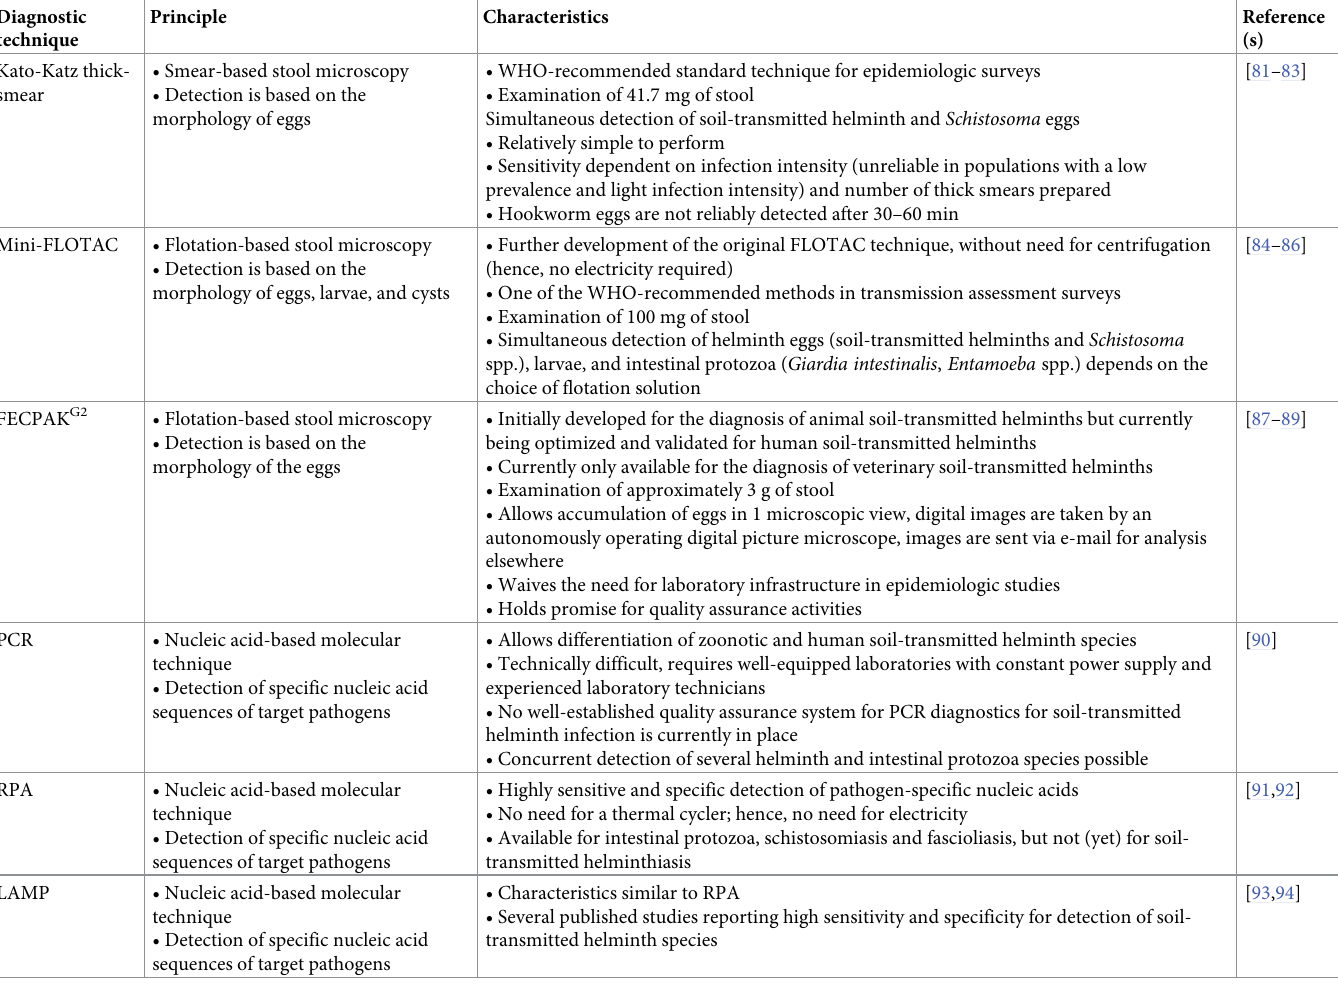
Table 3. Brief characterization of the Kato–Katz technique and selected other diagnostic developments for detection of soil-transmitted helminths, which might potentially be used in soil-transmitted helminthiasis control programs and epidemiologic